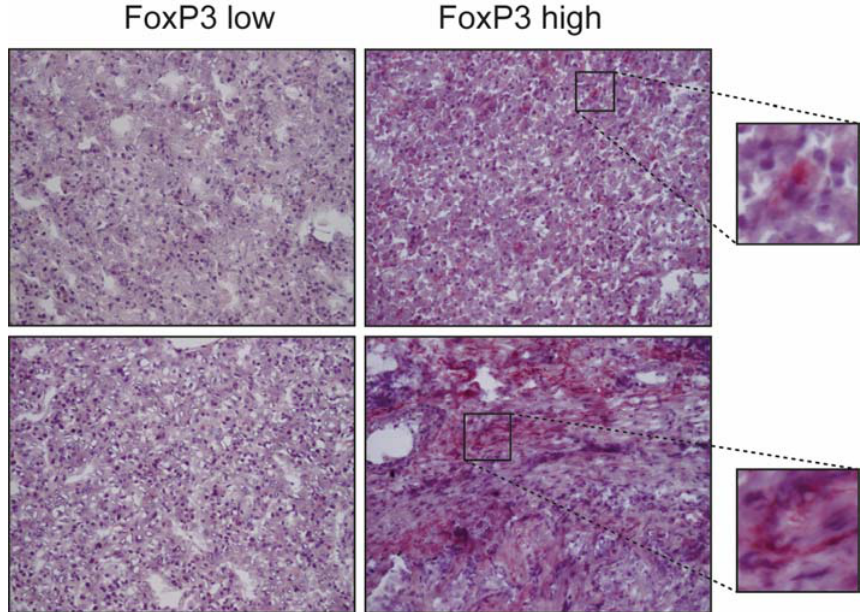
Figure 1. FoxP3 expression in 4 hepatocellular carcinoma (HCC) samples. FoxP3-positive cells belong principally to the CD4 + Treg subset, the presence of which is widely variable in different HCC tissues. The distribution pattern of FoxP3 does not show an apparent preference for any tumour sub-localization, as Tregs are found in parenchymal as well as stromal areas of HCC (upper right and lower right images, respectively). Representative images at 10 × . The small images are a 200 × of the selected area.